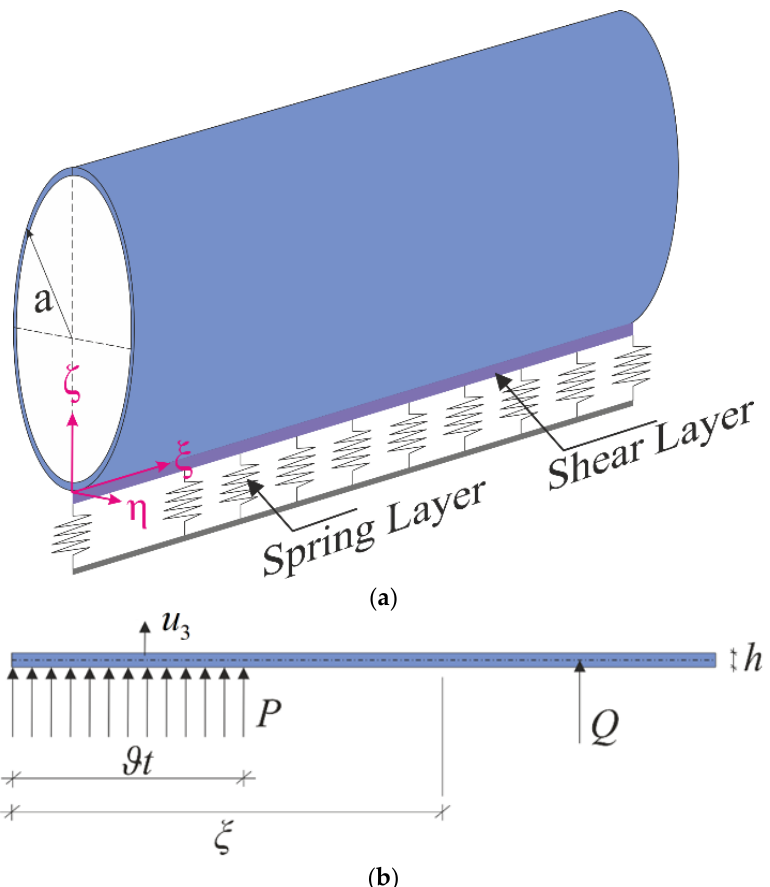
Figure 1. Scheme of an infinitely long cylindrical pipe ( a ) resting on the Pasternak elastic foundation ( b ) subjected to internal pressure P and annular pressure Q .